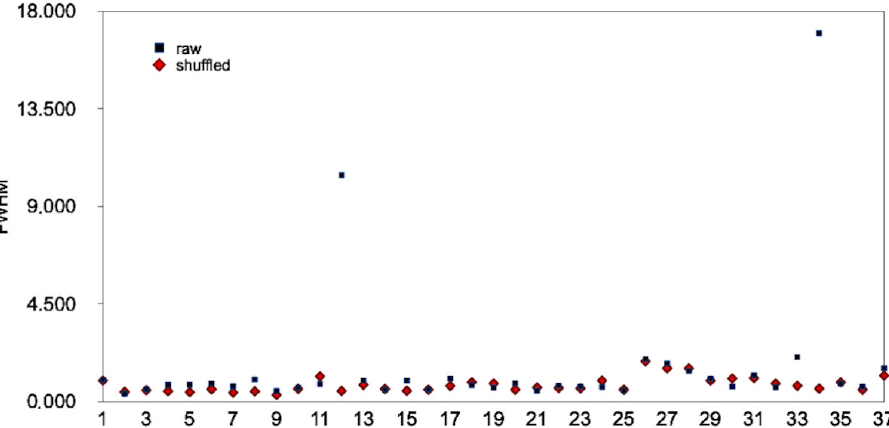
Figure 8. Scatter plot of FWHM values versus the i/i value of Table 2. Blue dots indicate the raw two-month series and the red dots the shuffled series.